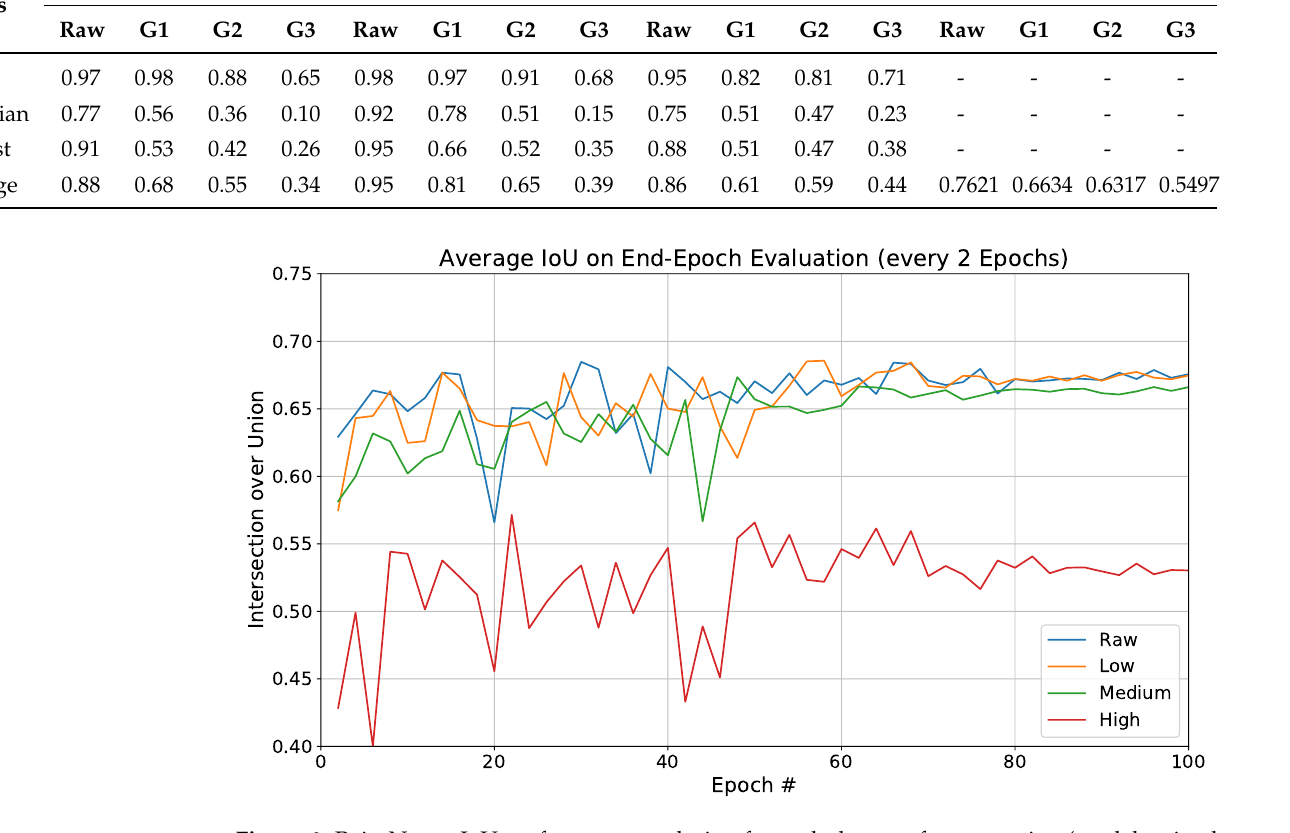
Figure 6. PointNet++ IoU performance evolution for each degree of compression (model trained with raw data). Test data is evaluated every two epochs. Table 4. Average IoU performance of PointNet++ model across classes, for varying degrees of point cloud